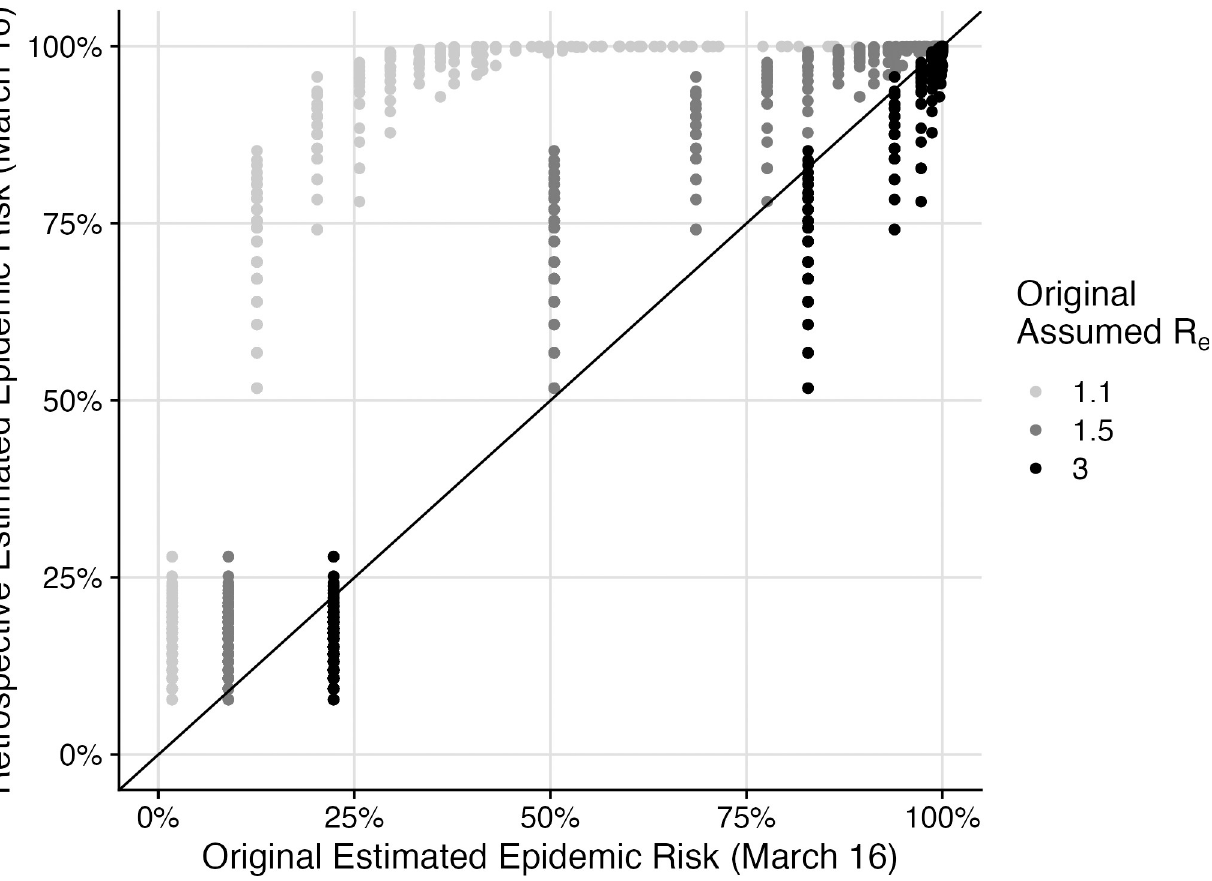
Fig 5. Comparison of original epidemic risk estimates, assuming a uniform R e across counties, and retrospective estimates, assuming empirical county-level estimates of R on March 16, 2020 across 3,142 US counties. Each point corresponds to a pair of risk estimates (original on x-axis vs e retrospective on y-axis) for a single county. Points are shaded according to the assumed effective reproduction number for the original estimate. The solid diagonal line indicates matching